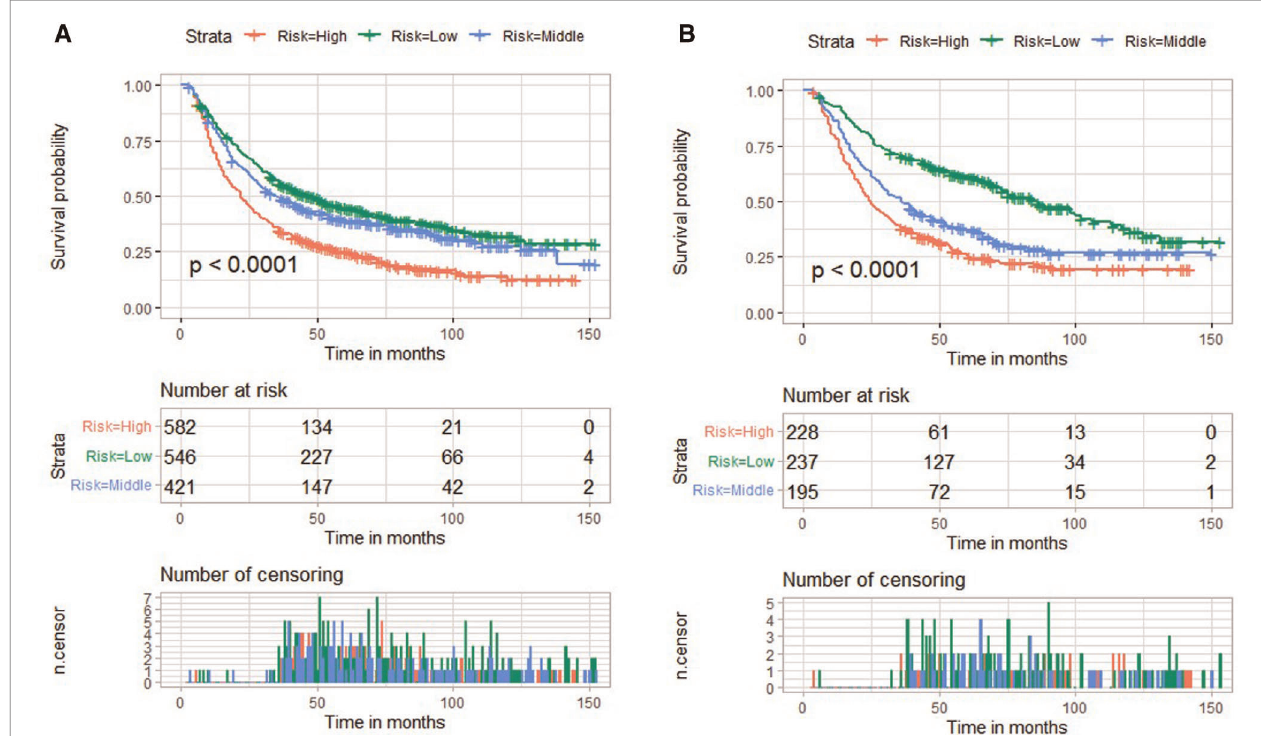
FIGURE 7 | Risk strati fi cation based on nomogram score and Kaplan – Meier curves for overall survival in the training cohort ( A ) and validation cohort ( B